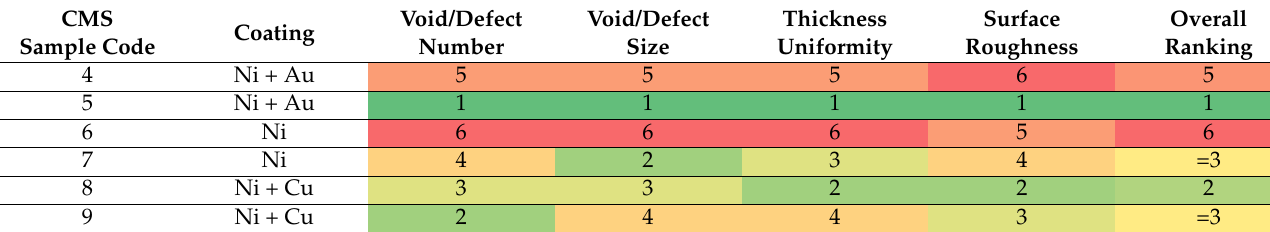
Table 9. Qualitative ranking of the joint samples, where 1 represents the optimal characteristics sample (in green) and 6 represents the worst characteristics (in red).